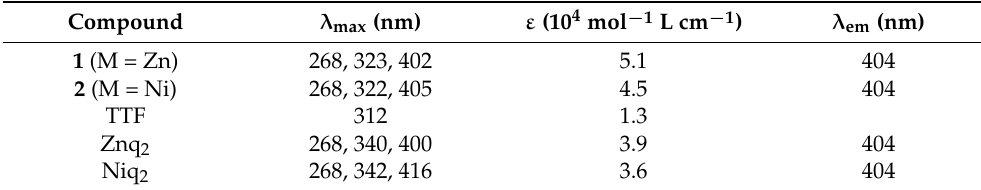
Table 2. Wavelength of maximum absorption peaks ( λ max ), absorption coefficients at 268 nm ( ε ) and emission peaks ( λ em ) under excitation light of 268